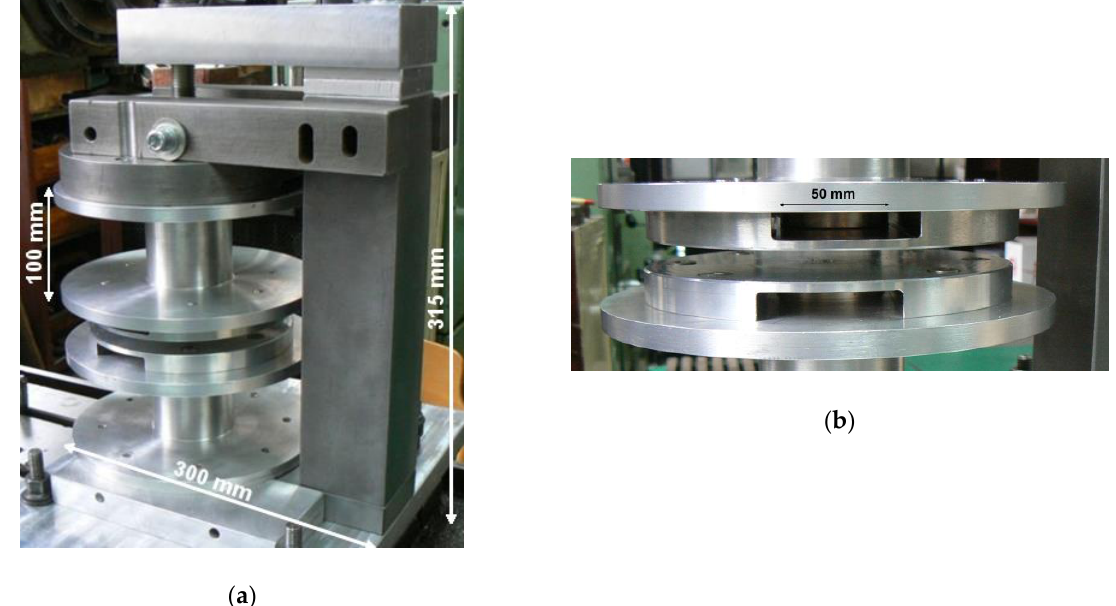
Figure 5. View of the experimental station for magnetic abrasive machining: ( a ) general view; ( b ) machining gap. Three neodymium magnets were installed in the upper and lower heads. Measure- ments of the maximum magnetic flux density values were carried out at the points